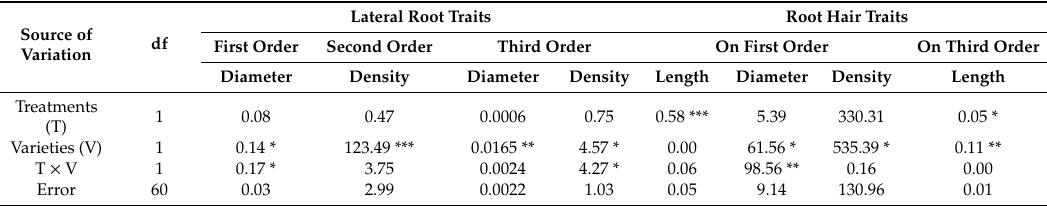
Table 2. Mean squares of the respective sources of variances with significance levels under salinity stress for lateral root and root hair